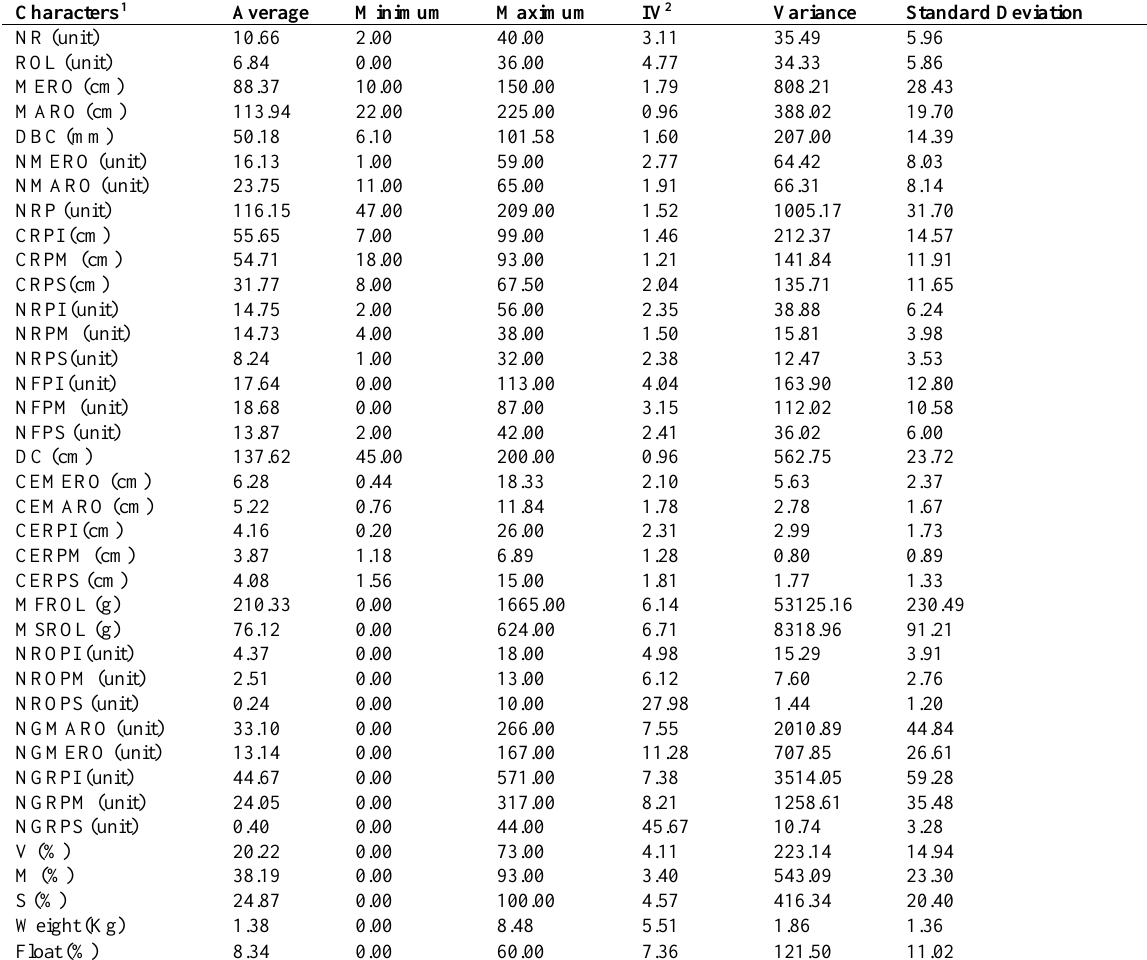
Table 1. Average characterization of 323 accessions of C. canephora based on the descriptive analysis of 38 characters evaluated at the Active Germplasm Bank (BAG), Experimental Farm of Bananal do Norte,